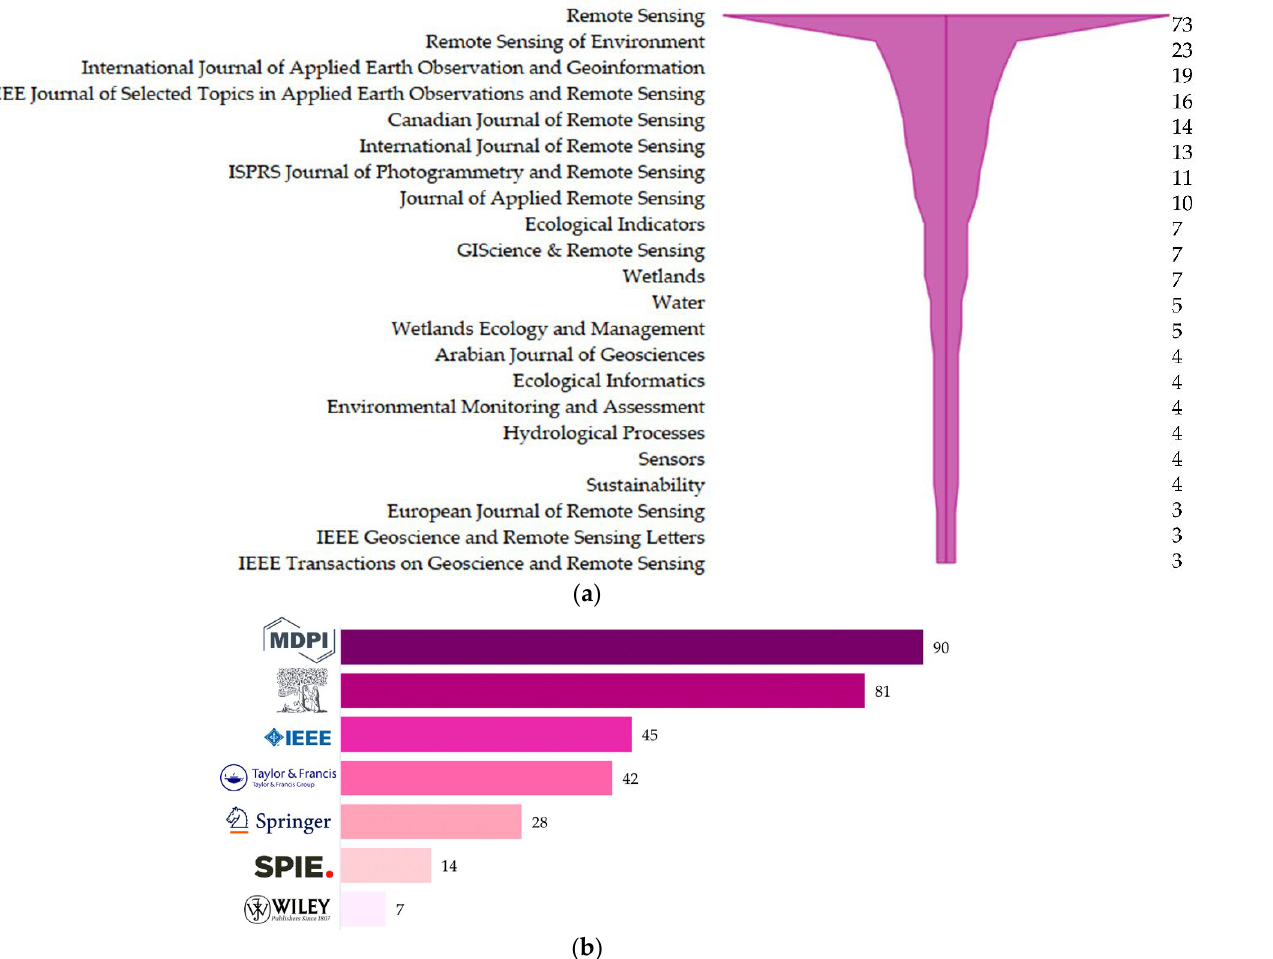
Figure 7. An overview of ( a ) the journals included in this meta-analysis and the number of papers per journal. ( b ) A listing of the leading publishers and the number of papers per publisher.